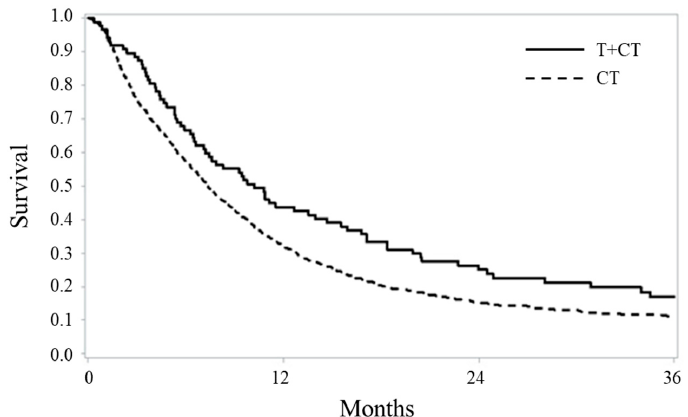
Figure 2. Kaplan–Meier estimates of overall survival in 87 and 1111 metastatic gastric cancer patients treated, respectively, with trastuzumab-based chemotherapy (T + CT) and standard chemotherapy (CT) alone. Table 2. Association between first-line treatment and overall survival in 87 metastatic gastric cancer patients treated with trastuzumab-based chemotherapy (T + CT) and 1111 patients treated with standard chemotherapy (CT).